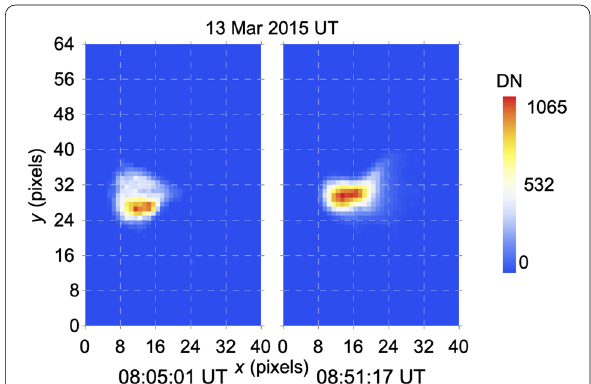
Fig. 8 Gain-corrected image of a bifurcation anomaly from Swarm A from 13 March 2015. Left panel: bifurcation of nominal ion peak associated with apparently larger kinetic energy (shift of peak to the left) than normal. Right panel: gain-corrected image obtained ∼ 46 min later showing no evidence of bifurcation in the same region of the detector, ruling out gain depletion or other detector anomaly as the root cause of the